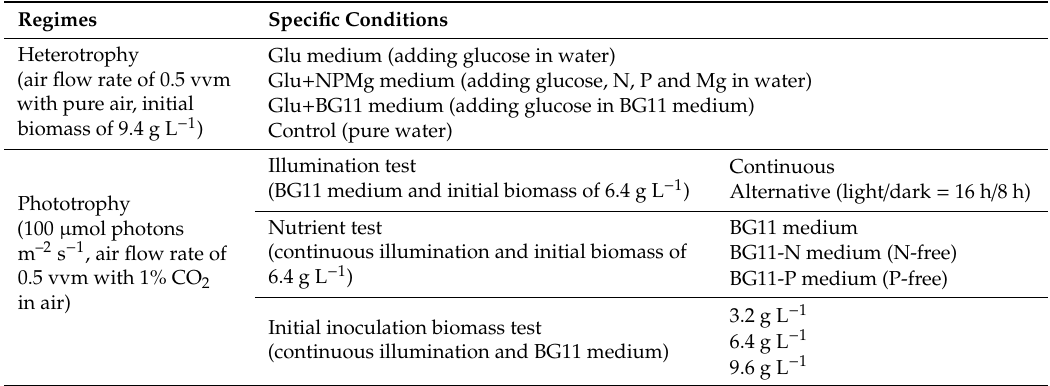
Table 3. Experimental arrangement for the lipid